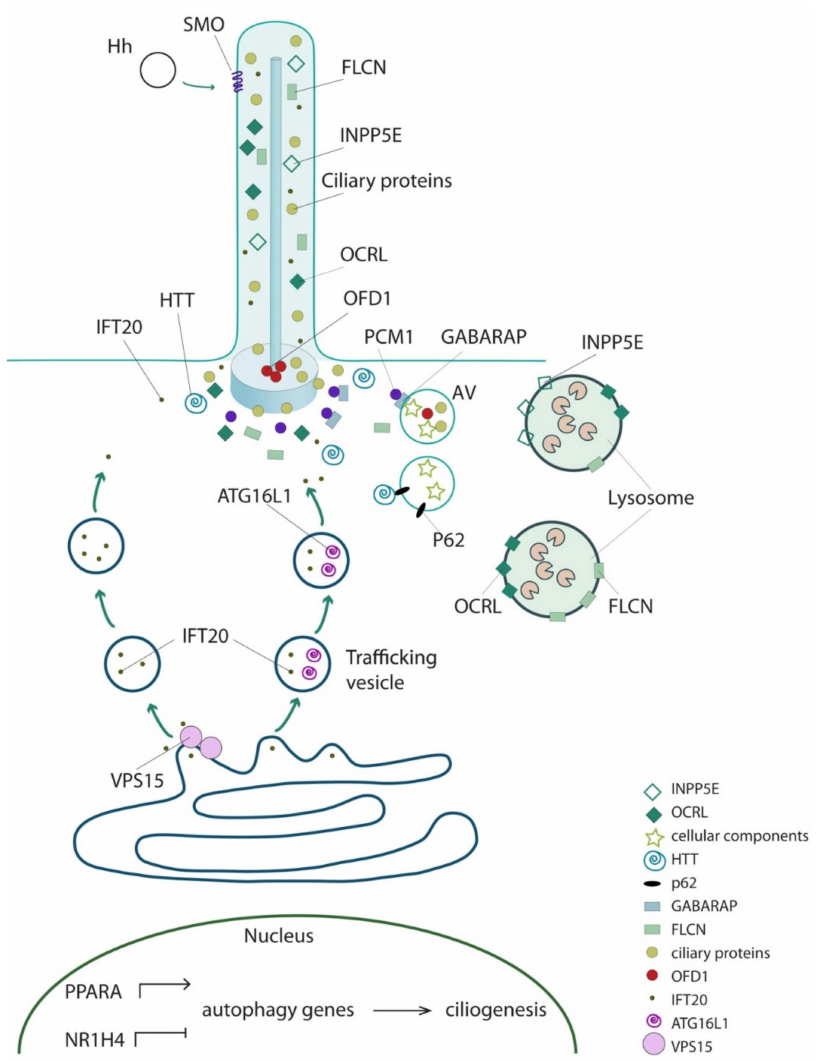
Figure 2. The interplay between ciliary and core autophagic proteins. Schematic representation of subcellular localization of cilioproteins exerting a direct functional role in autophagy. AV: autophagic